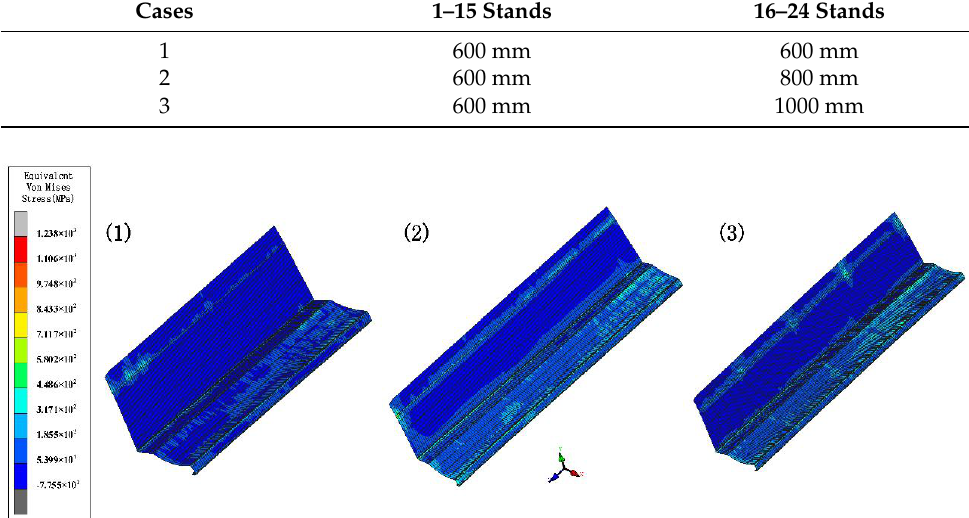
Table 4. Different inter – distance cases.